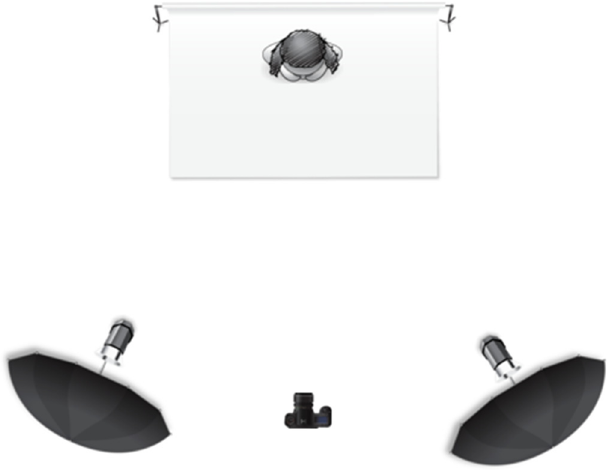
Fig 1. Lighting setup diagram. Visualisation was generated by the online free service